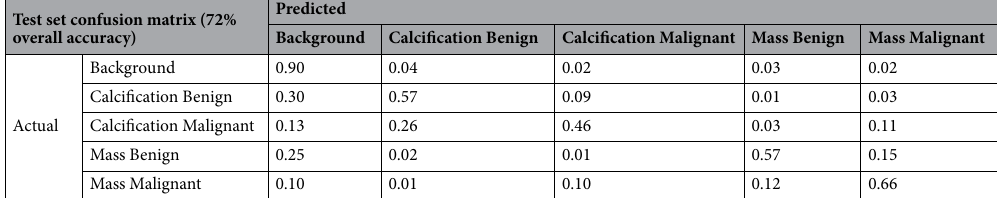
Table 1. Confusion matrix of the CNN classifier for the test set. The rows are normalised (each sums to one) to show the correctly classified proportion in each class, namely: Background, Calcification Benign, Calcification Malignant, Mass Benign and Mass